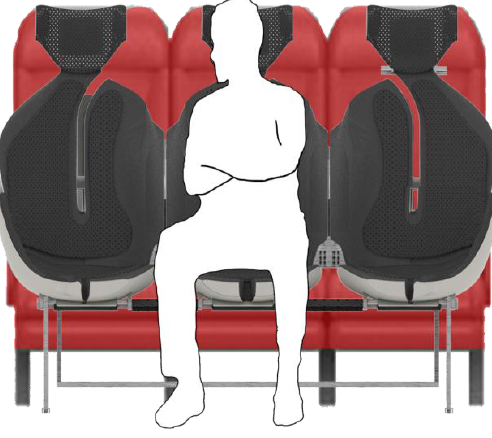
Figure 35. Material and cost saving new design.